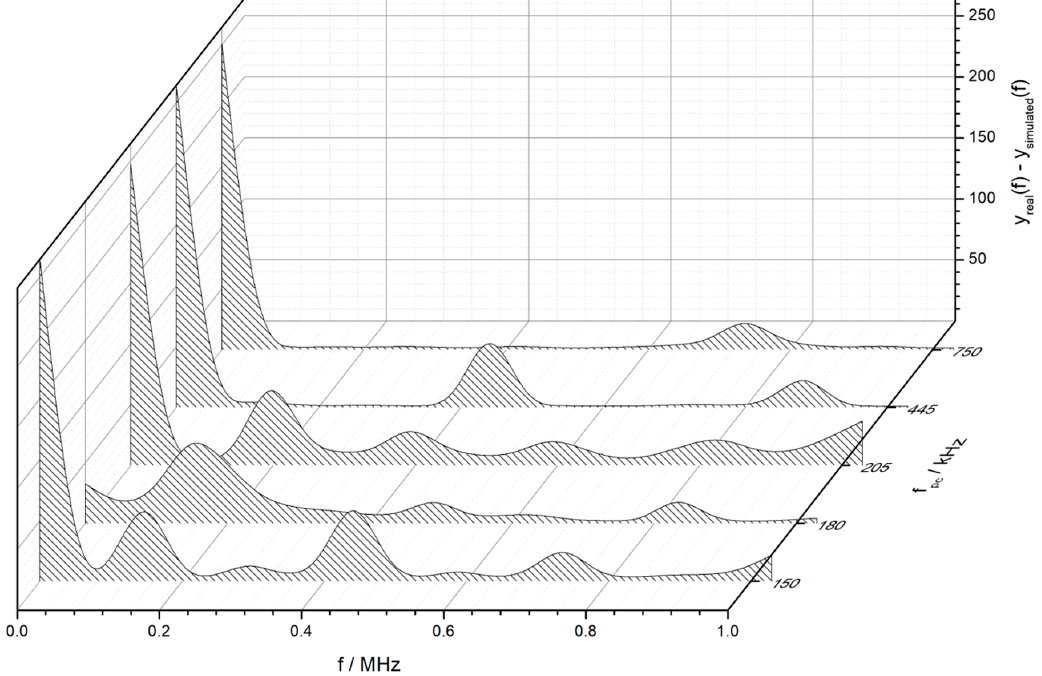
Figure 4. Real and simulated signals spectrums subtraction at 150 kHz, 180 kHz, 205 kHz, 445 kHz and 750 kHz high voltage pulse frequencies. and 750 kHz high voltage pulse